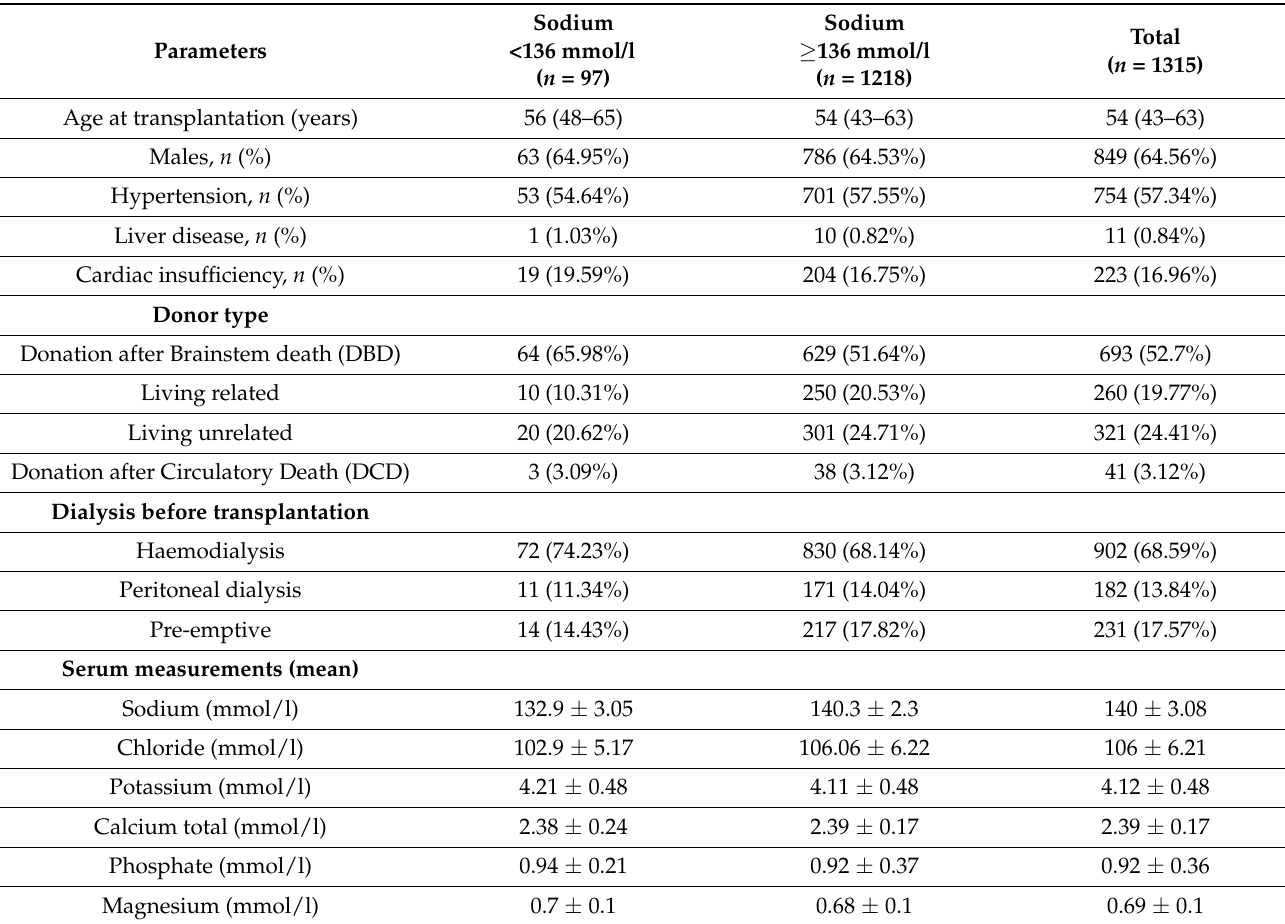
Figure 1. Flowchart illustrating patient recruitment. Table 1. Baseline characteristics of the study population ( n = 1315): clinical parameters, co-morbidities, transplantation information, outcome.